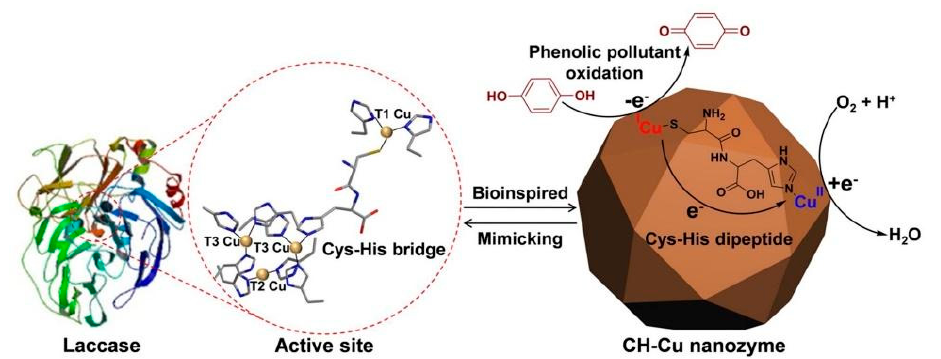
Figure 19. Cysteine-histidine Cu nanozyme for the oxidation of phenolic pollutant. (Reprinted with permission from [173] . Copyright © 2019, Elsevier B.V. All rights reserved). permission from [173]. Copyright © 2019, Elsevier B.V. All rights